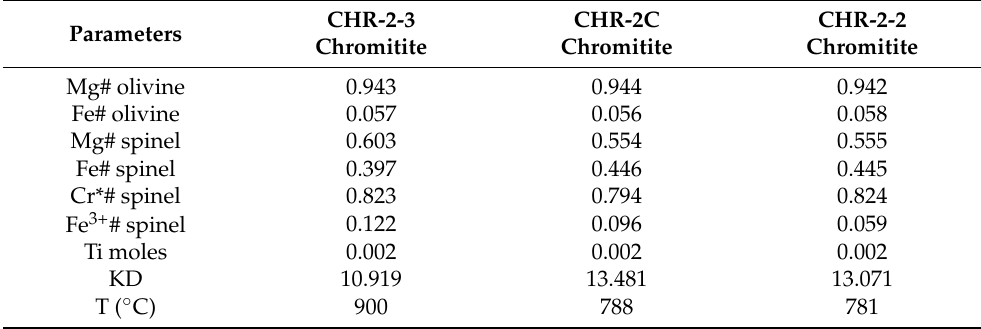
Table 3. Estimated primary temperatures and parameters for the olivine-spinel geothermometer according to Ballhaus [43]. The assumed pressure is 0.3